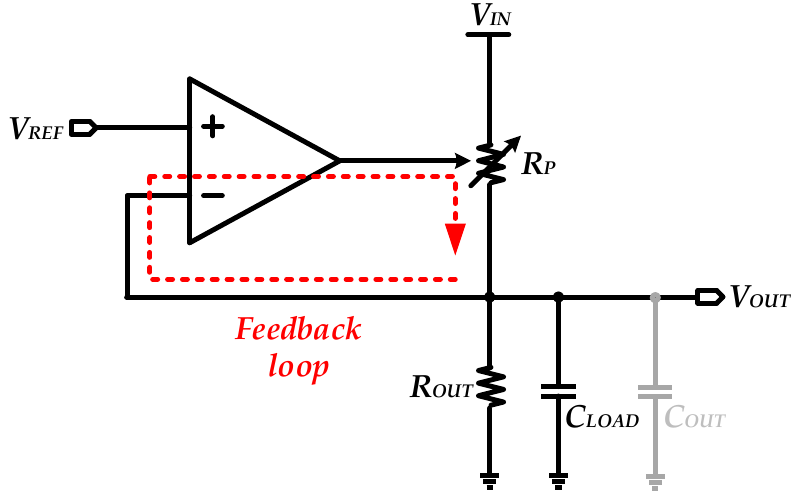
Figure 1. Conventional low-dropout (LDO) regulator.